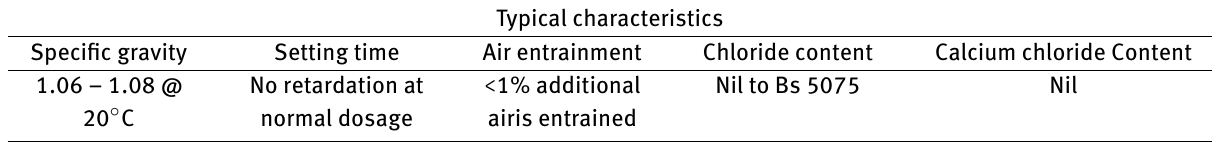
Table 2: Properties of